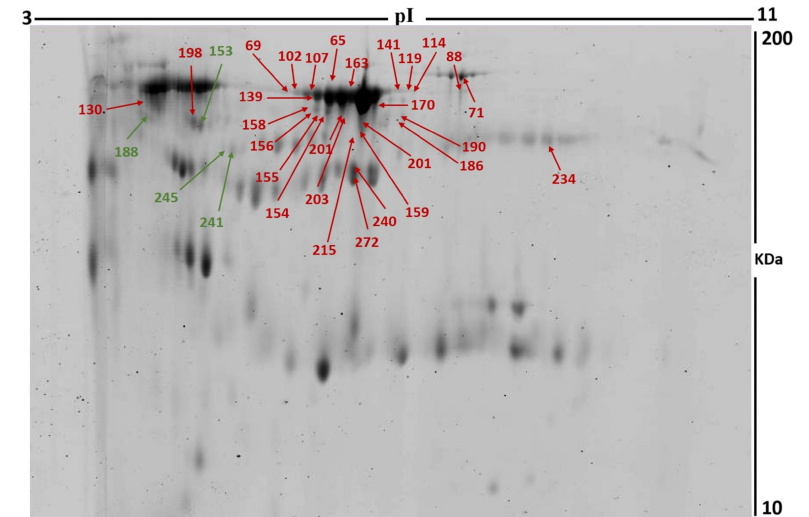
Figure 2. 2D-DIGE numbered spots indicate proteins with differential abundance (defined as fold- change ≥ 1.5, p ≤ 0.05) between pre-treated and post-treated samples successfully identified with matrix-assisted laser desorption/ionization time-of-flight (MALDI TOF) mass spectrometry (MS). MW, protein molecular weight; pI, isoelectric